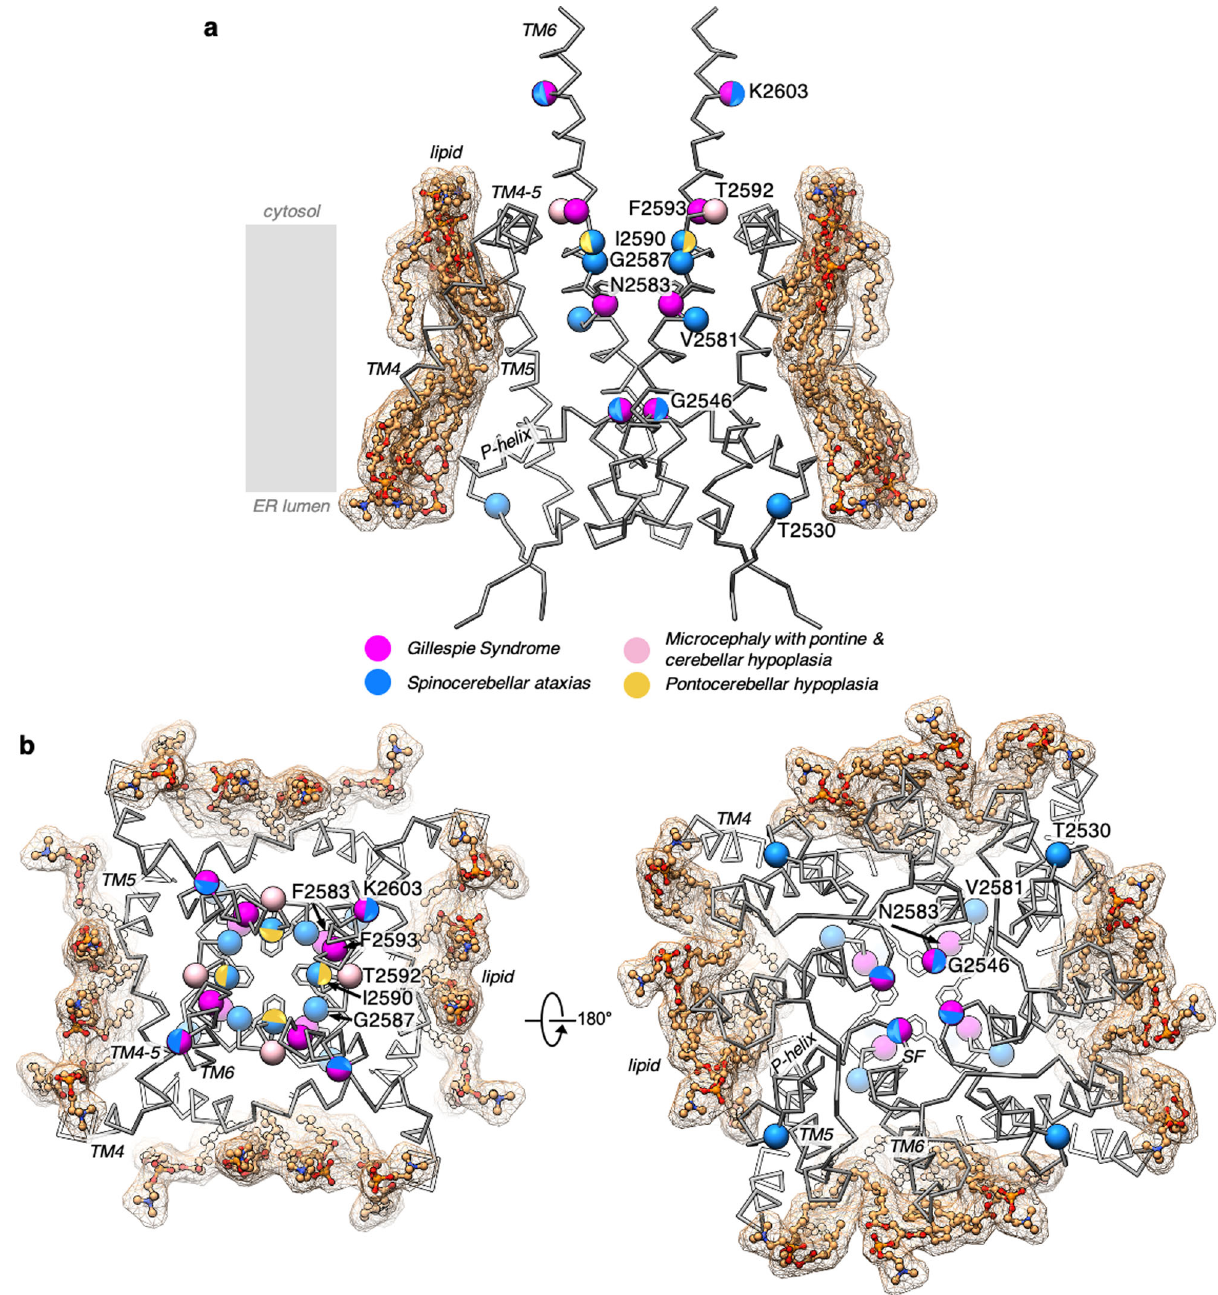
Fig. 5 Model of disease-associated mutations in TM domains of IP 3 R1. a TM4 – TM6 helices (gray, wire representation) from two opposing subunits of IP 3 R1-ND are shown in side view; lipid molecules (orange) are depicted as ball-and-stick models overlapped with corresponding surface representations (mesh). Residues in the rat IP 3 R1 sequence that correspond to the human IP 3 R1 mutations associated with Gillespie Syndrome, microcephaly with pontine and cerebellar hypoplasia, spinocerebellar ataxias, and pontocerebellar hypoplasia are depicted as spheres and colored magenta, pink, blue, and yellow, respectively. b TM4 – TM6 helices of four subunits with lipids viewed from the cytosol (left panel) and lumen (right panel) perpendicular to the membrane